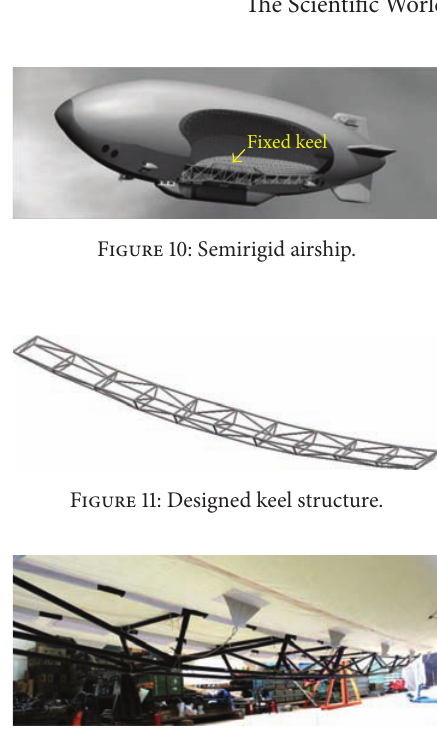
Figure 12: Designed keel structure in